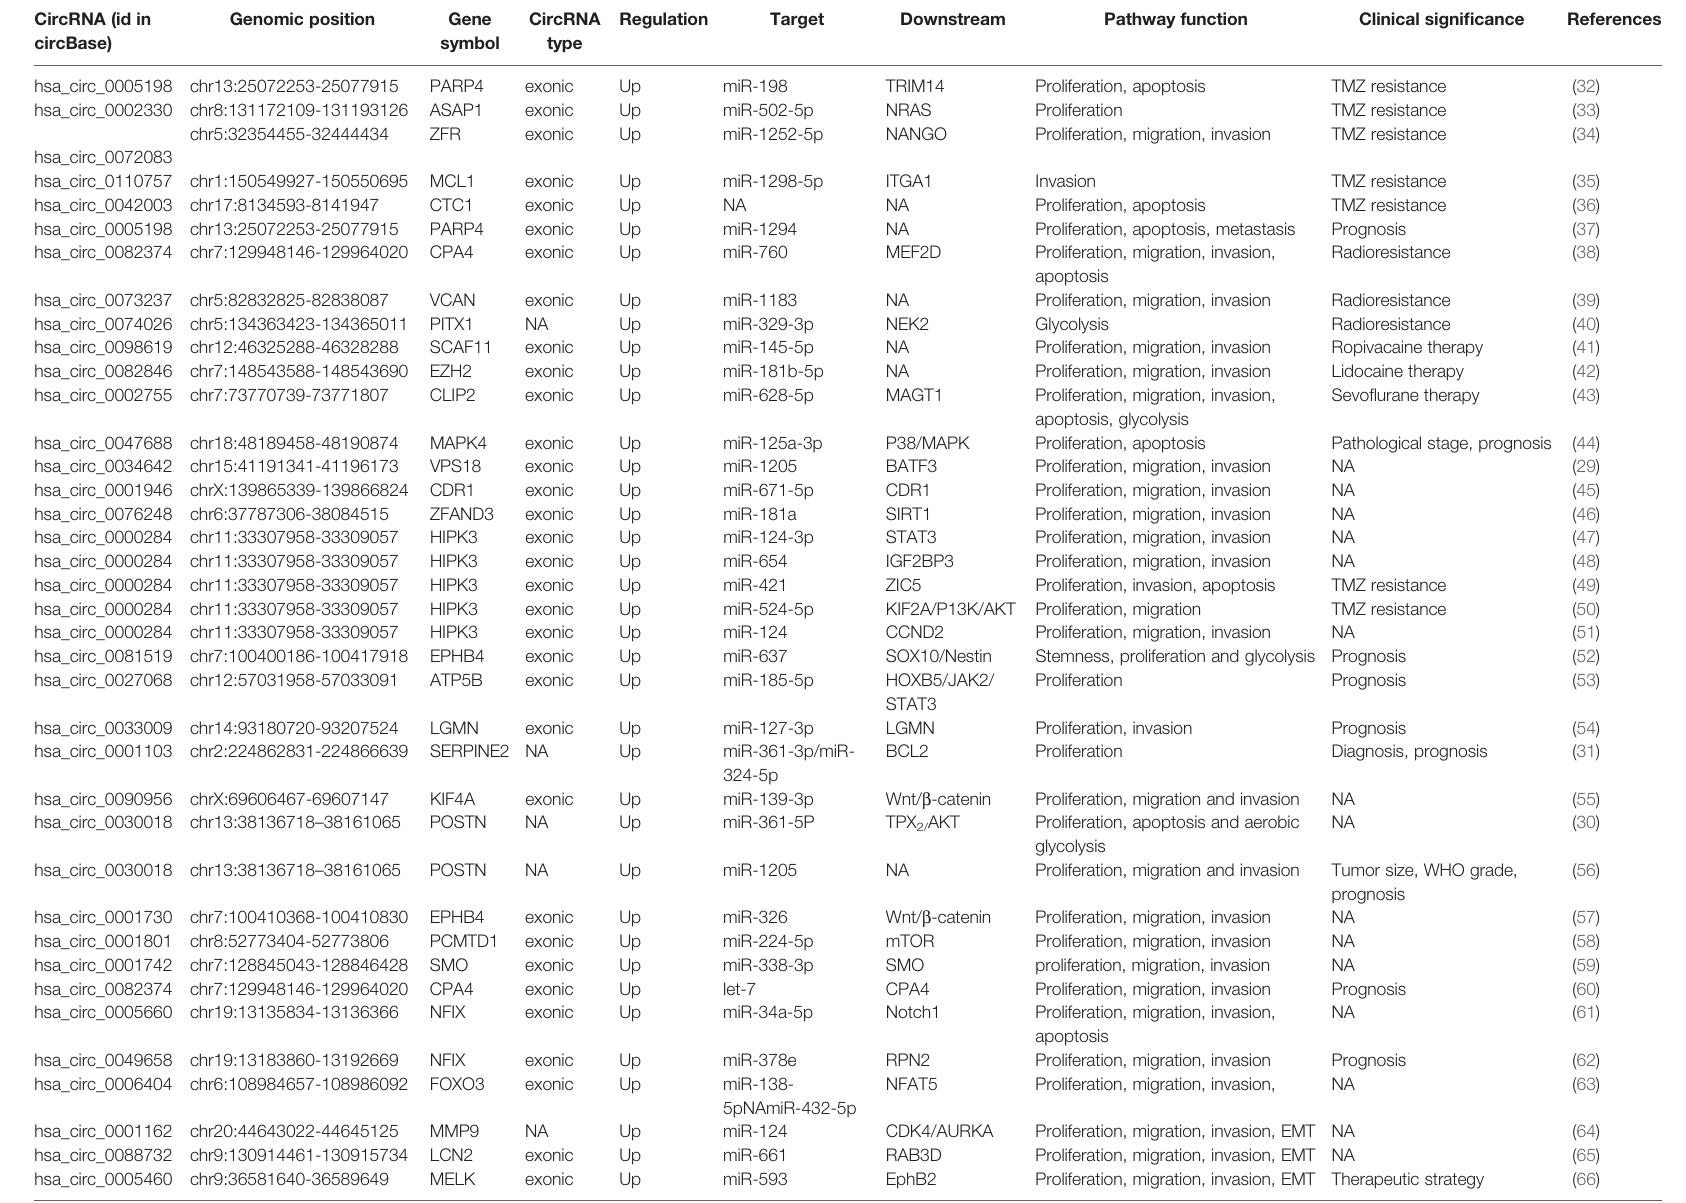
TABLE 1 | CircRNAs and corresponding signaling pathways in